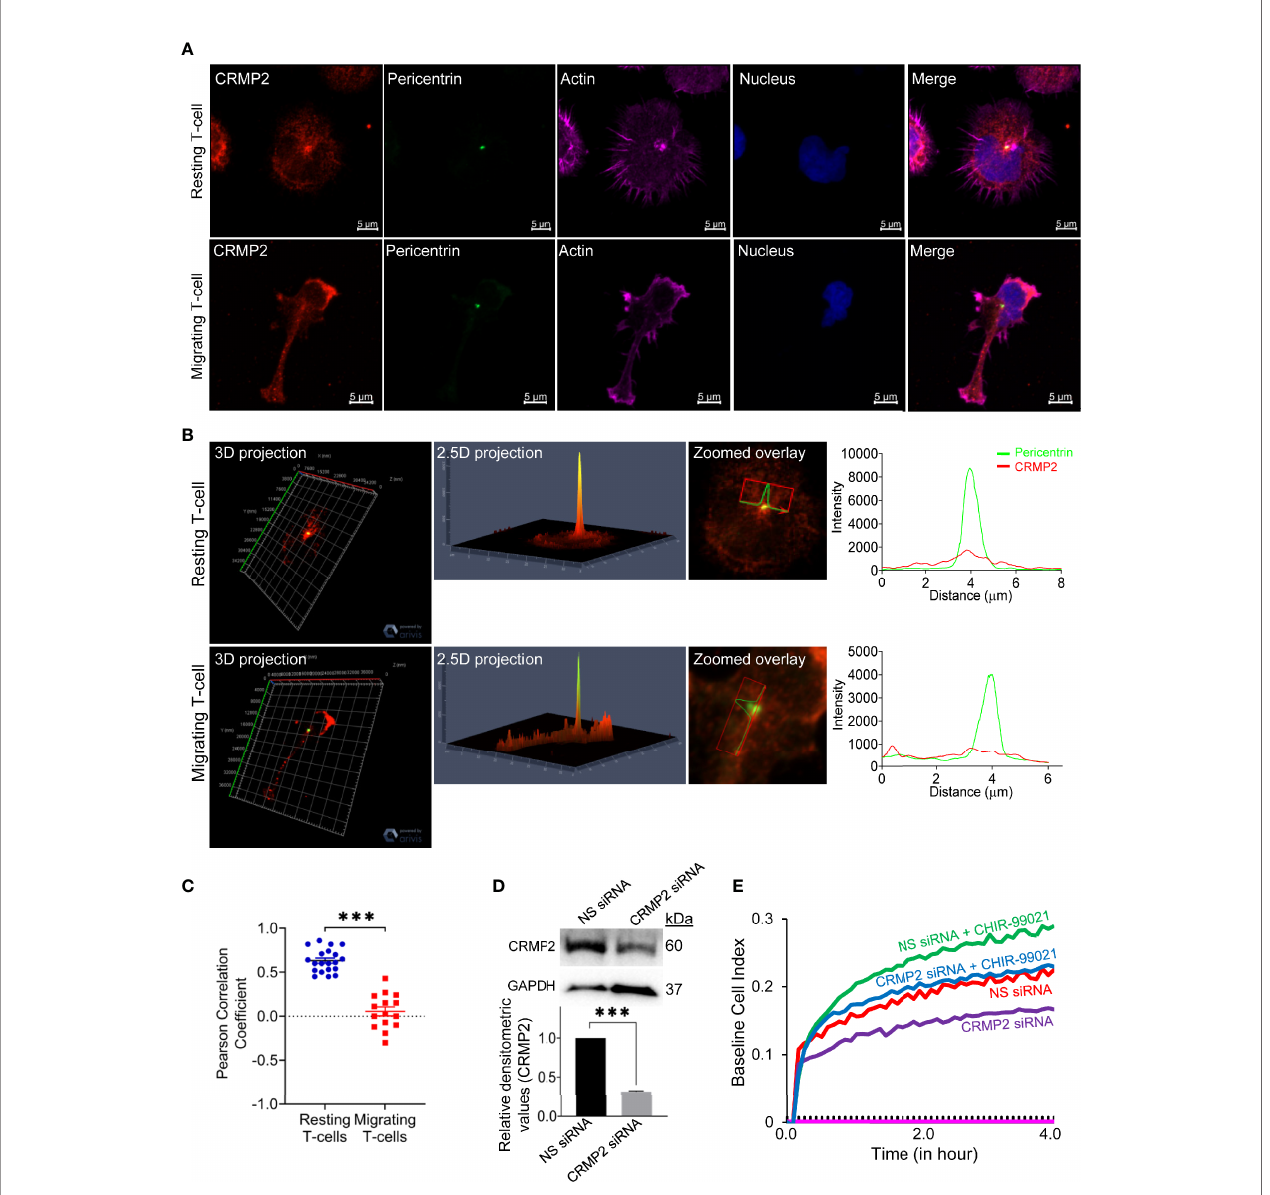
FIGURE 5 | CRMP2 colocalization to the MTOC and the effect of CRMP2 depletion on T-cell motility. (A) Resting and LFA-1-stimulated HuT78 T-cells were immunostained with anti-CRMP2/Alexa Fluor ® 568 ( red ), anti-pericentrin/Alexa Fluor ® 488 ( green ), phalloidin-Alexa Fluor ® 647 (actin, pink ) and Hoechst (nucleus, blue ). Cells were then imaged by confocal laser scanning microscopy, array scan 63X objective. (B) 3D and 2.5D projections, zoomed overlay and intensity pro fi les (replotted using the GraphPad Prism software) of CRMP2 and pericentrin are shown. (C) Pearson Correlation Coef fi cient between CRMP2 and pericentrin was assessed using Carl Zeiss ZEN Black software. Each dot represents a single T-cell, and the images were taken from at least three independent experiments; n=20 for resting T-cells and n=15 for migrating T-cells; error bar, mean ± SEM. (D) PBL T-cells were nucleofected with 100 nM siRNA targeting CRMP2 or non-speci fi c ( NS ) siRNA. After 72 h, cells were lysed, Western immunoblotted and probed for CRMP2. Blots were re-probed for GAPDH as a loading control. Relative densitometry values for CRMP2/GAPDH were determined and plotted (mean ± SEM). (E) The control ( NS siRNA ) and CRMP2-depleted ( CRMP2 siRNA ) PBL T-cells were treated with 5 µM CHIR-99021 for 2 h and then allowed to migrate on rICAM-1-coated E-Plate 16 for 4 h. Cell migration was recorded in real-time using impedance-based measurements by the RTCA instrument. Wells without cells were used to automatically draw the baseline. Data represent at least three independent experiments. ***p <